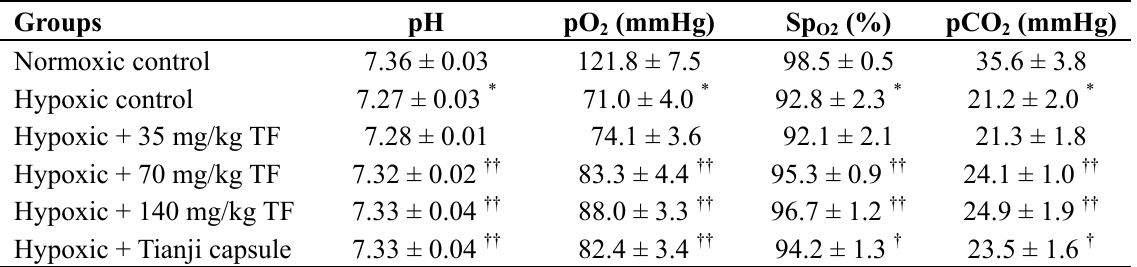
Table 4. Effect of total flavonoids of seabuckthorn on blood gases variables in high-altitude polycythemia